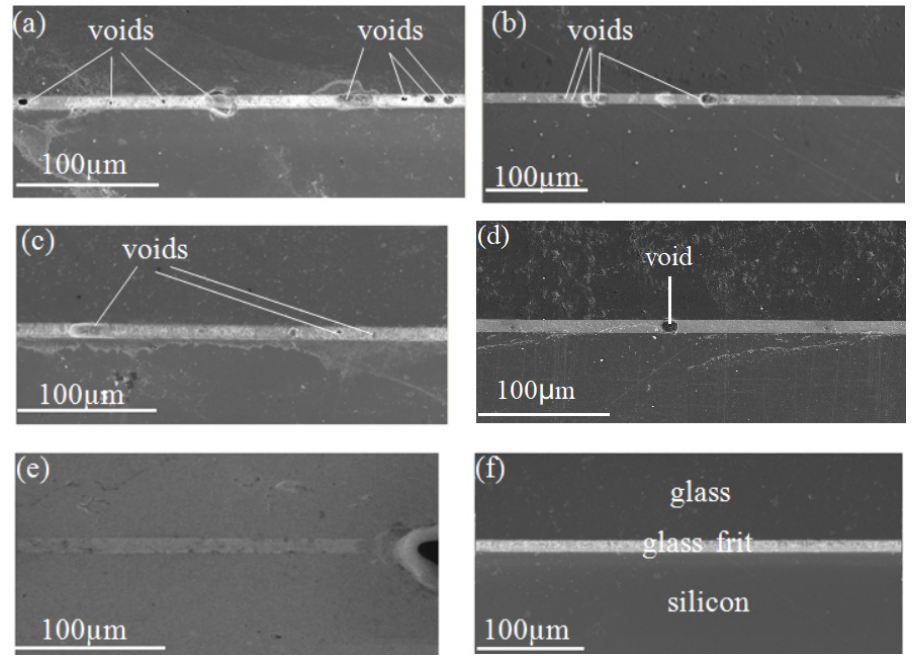
Figure 4. Cross sectional SEM image of glass frit bonds: ( a , b ) Annealing in air and under vacuum at 400 °C for 60 min, respectively; ( c ) Annealing in air at 450 °C for 30 min and annealing under vacuum at 450 °C for 30 min; ( d , e ) Annealing in air at 450 °C for 30 min and annealing under vacuum